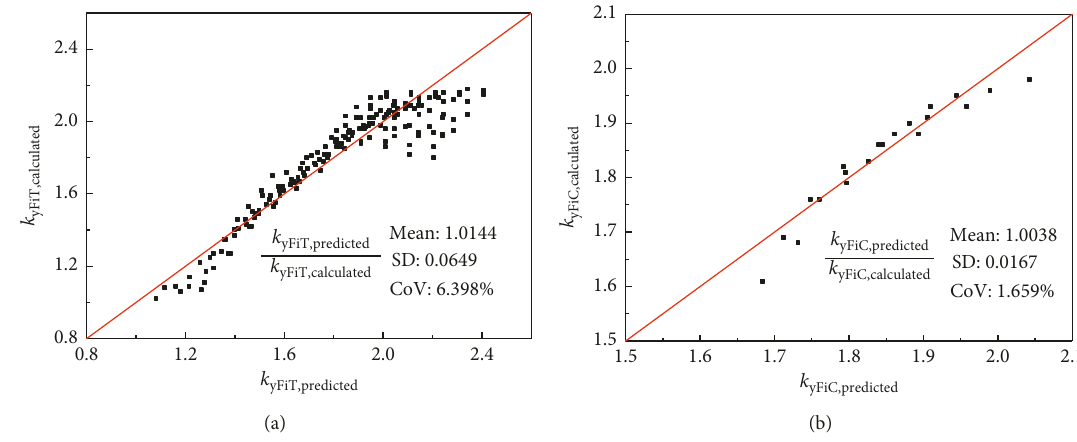
Figure 12: Calculated and predicted yield curvature coefficients. (a) Flange in tension. (b) Flange in